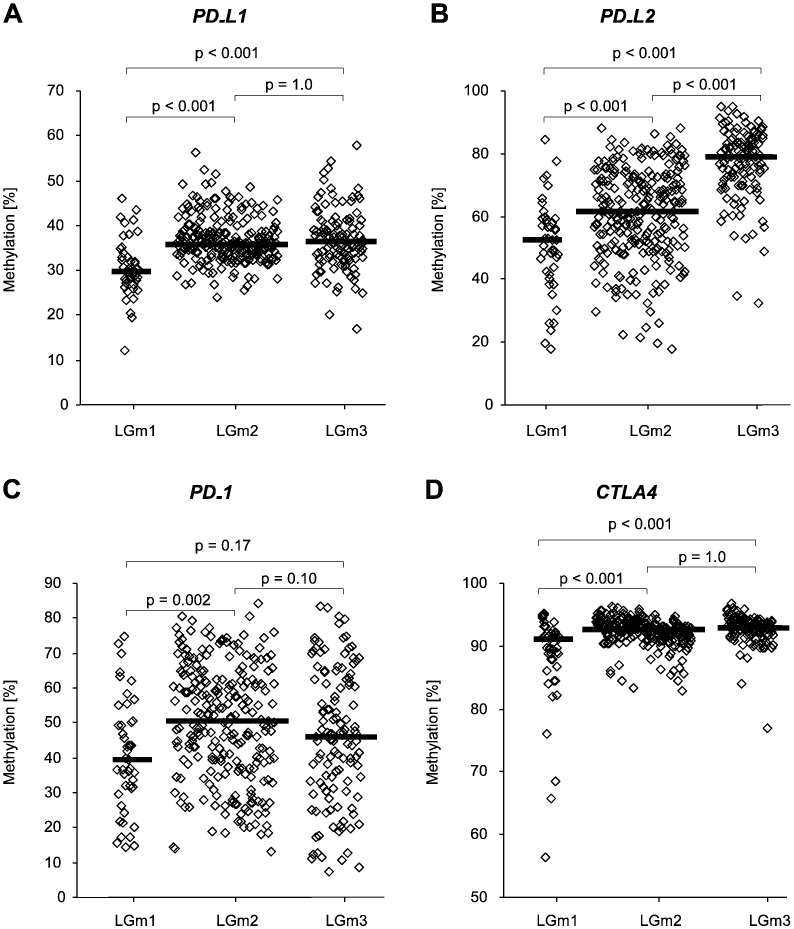
Methylation of immune checkpoint genes PD-L1 (A), PD-L2 (B), PD-1 (C), and CTLA4 (D) in diffuse lower-grade glioma patients (n = 419) with respect to methylation subtypes (LGm1, LGm2, LGm3). Bars indicate median. p-Values refer to ANOVA with Bonferroni Post hoc test.